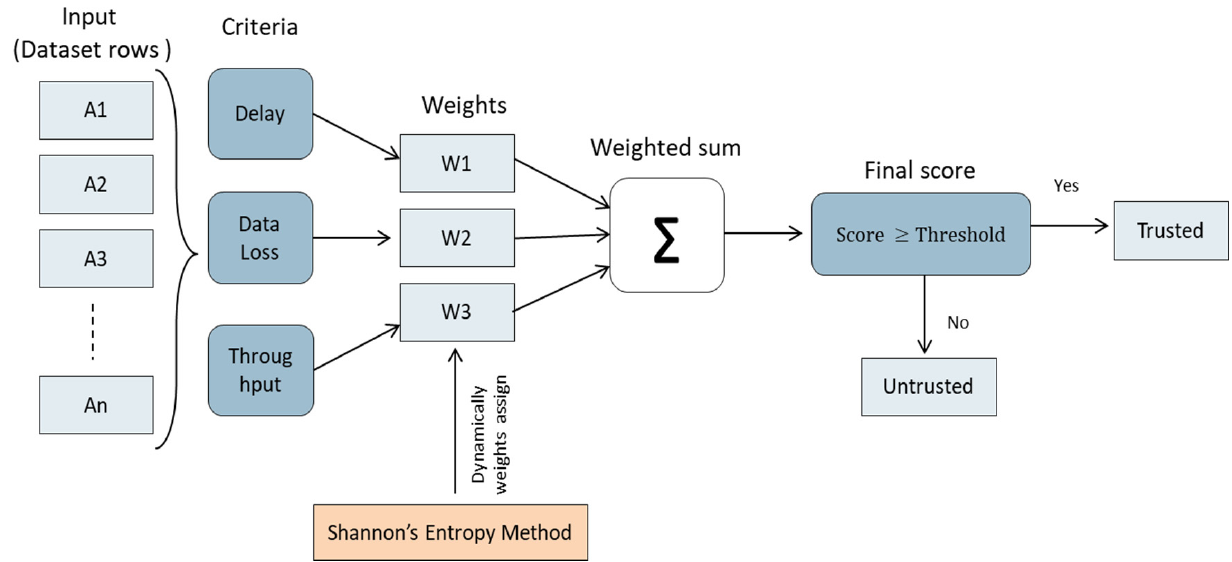
Figure 4. Trust value calculation using the SMART technique.